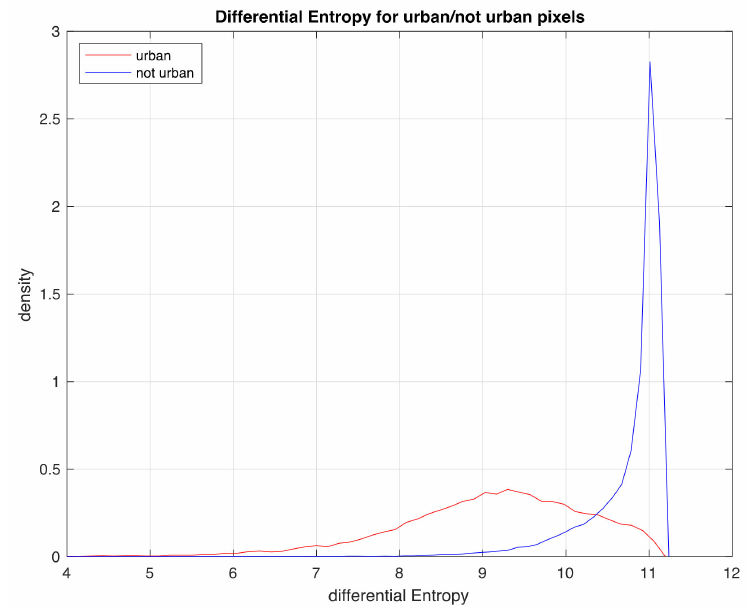
Figure 2. Differential entropy probability density estimation. Computed for a stack of 8 SAR images with 6 days temporal baseline over Lainate, Italy. A spatial window of 25 × 5 samples was